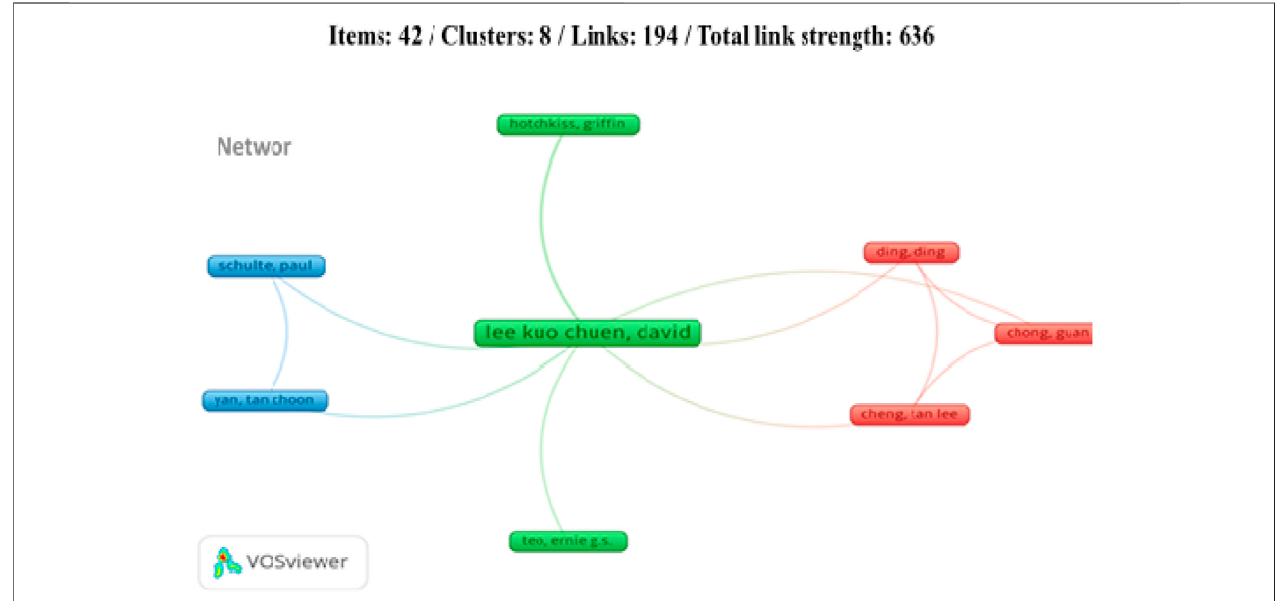
FIGURE 5 | (A) Network of authors. (B) Density of authors.